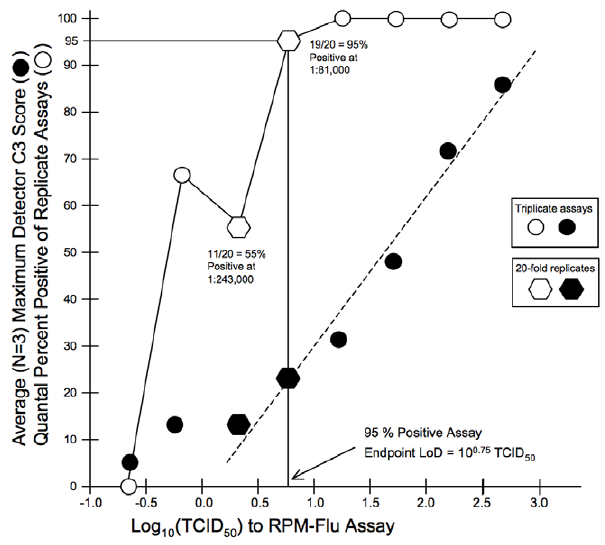
Figure 6. Limit of Detection (LoD) determination for seasonal A/H3N2 strain BRD10601. Neat stock of cell culture lysate (1.78 6 10 ˆ 7 TCID 50 /ml) was diluted 1:1,000 in cell culture media. Triplicates at this dilution, and at serial three-fold dilutions to 1:2,187,000 were individually extracted and subjected to RPM-Flu assay. Black circles indicate average of the maximum C3 Score (from either HA3, NA2 or M(H3N2) detector tiles) at each dilution, plotted against log 10 TCID 50 input per assay. Open circles represent the quantal percentage of positive assays (out of three) at each dilution tier. The open and black hexagons correspond to a dilution tier at which 20-fold replicates were assayed to demonstrate the 95% endpoint LoD, in this case corresponding to assay input of about 6 TCID 50